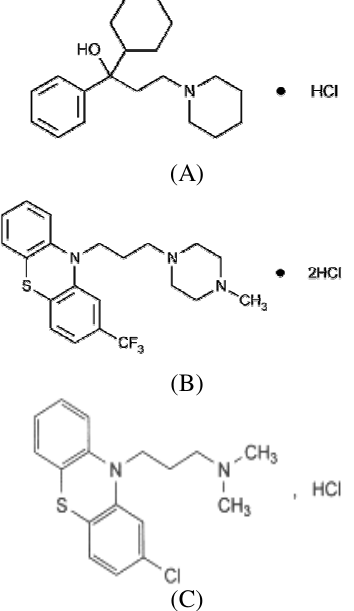
Figure 1. Chemical structure of (A)THP, (B)TFP and